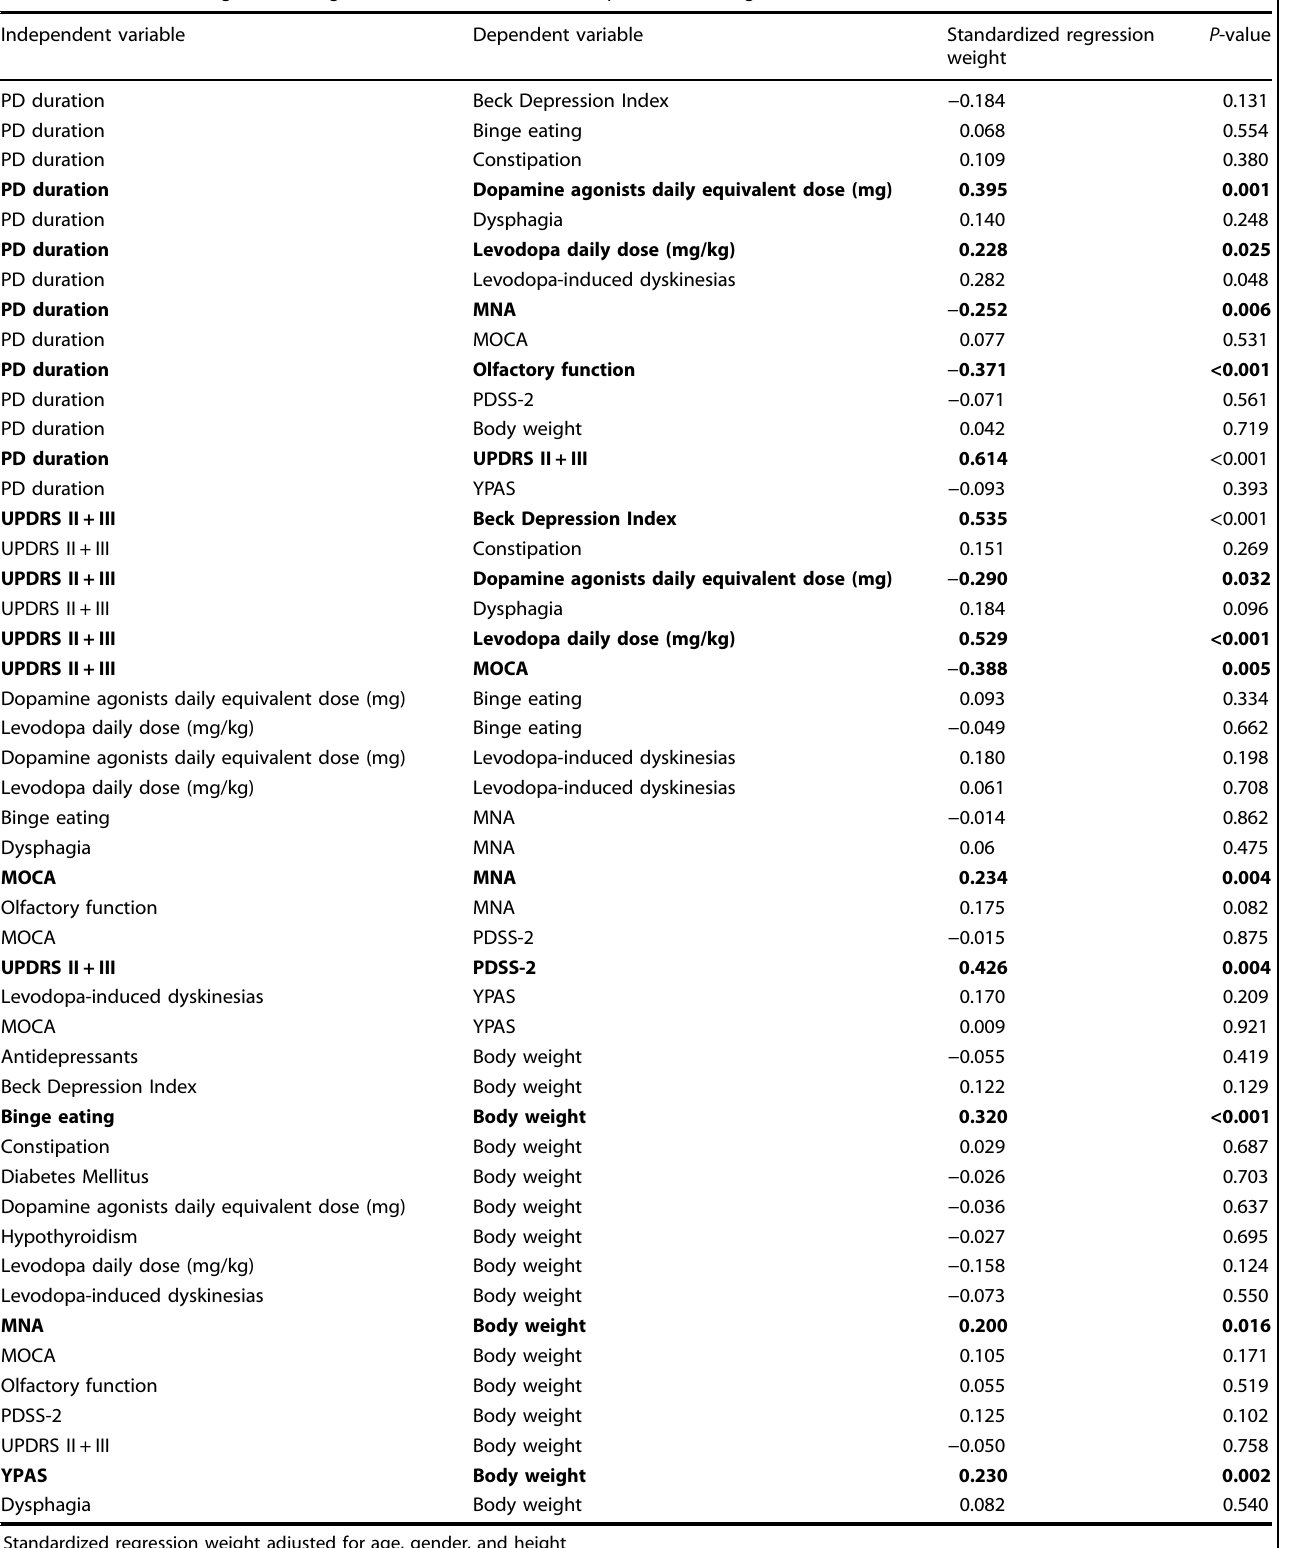
Table 2. Standardized regression weight calculated with structural equation